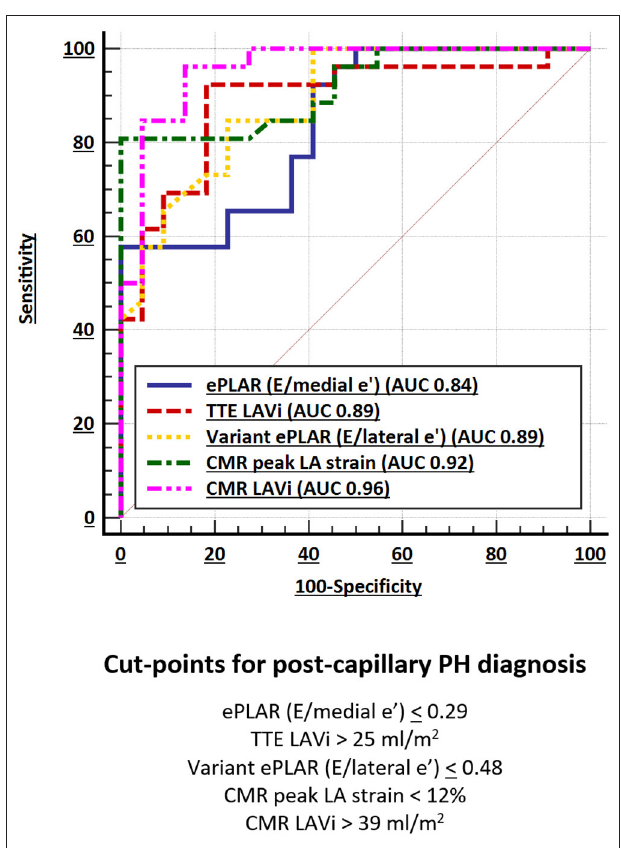
FIGURE 2 | Comparison of selected TTE and CMR discriminator